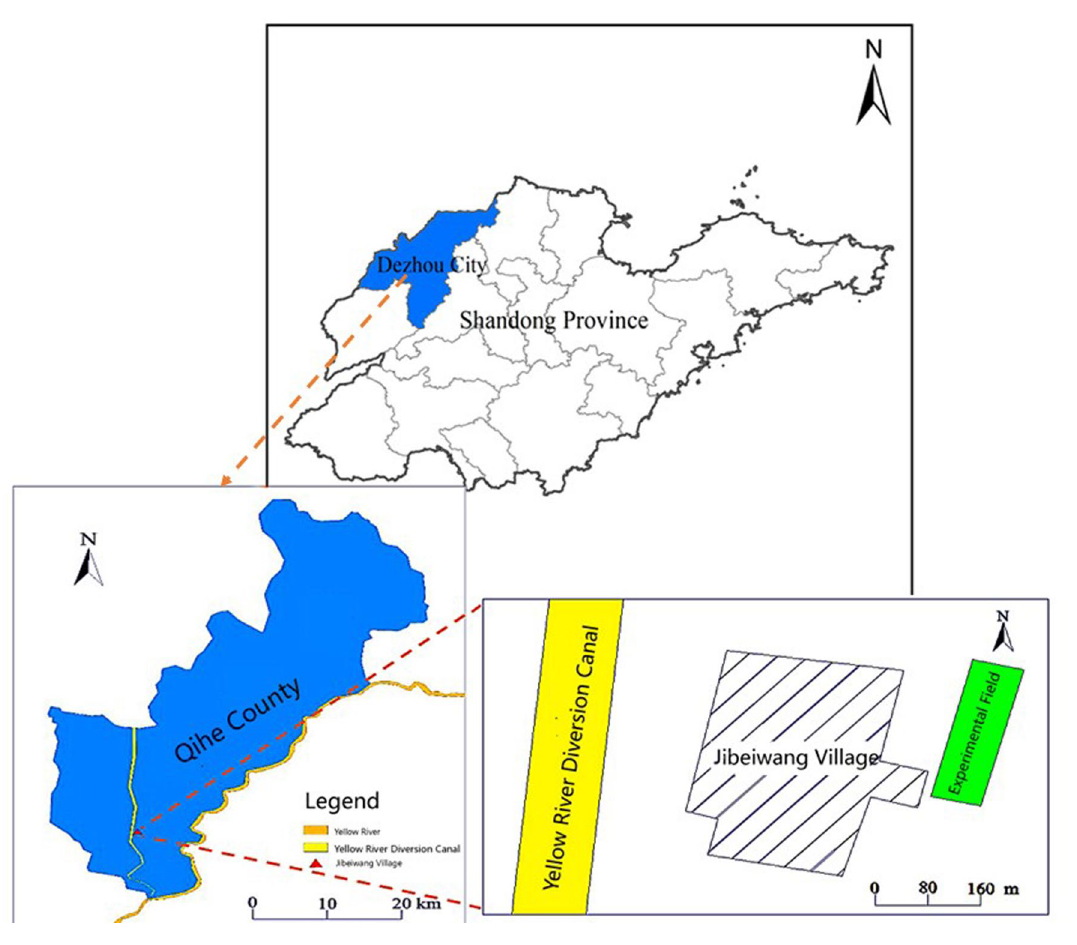
Fig. 1 Location map of the experimental site